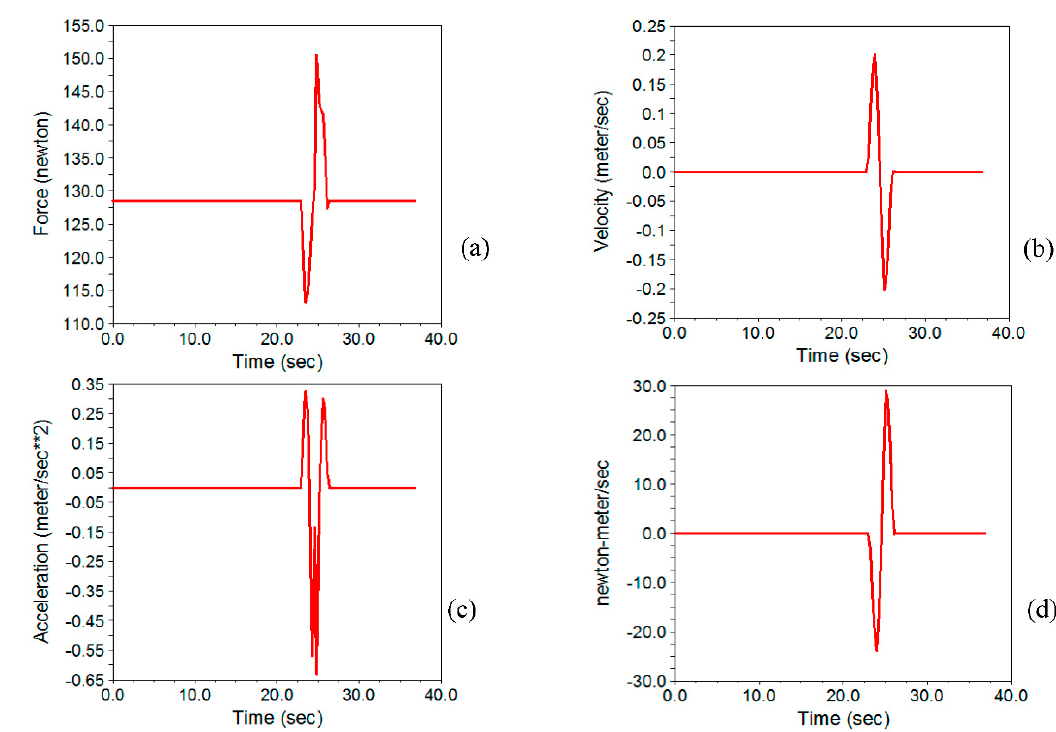
Figure 20. Results of ADAMS software to determine the characteristics of the jack of the head-cutting subset (four fish per minute). In this figure, ( a – d ) are force, velocity, acceleration, and required power respectively.